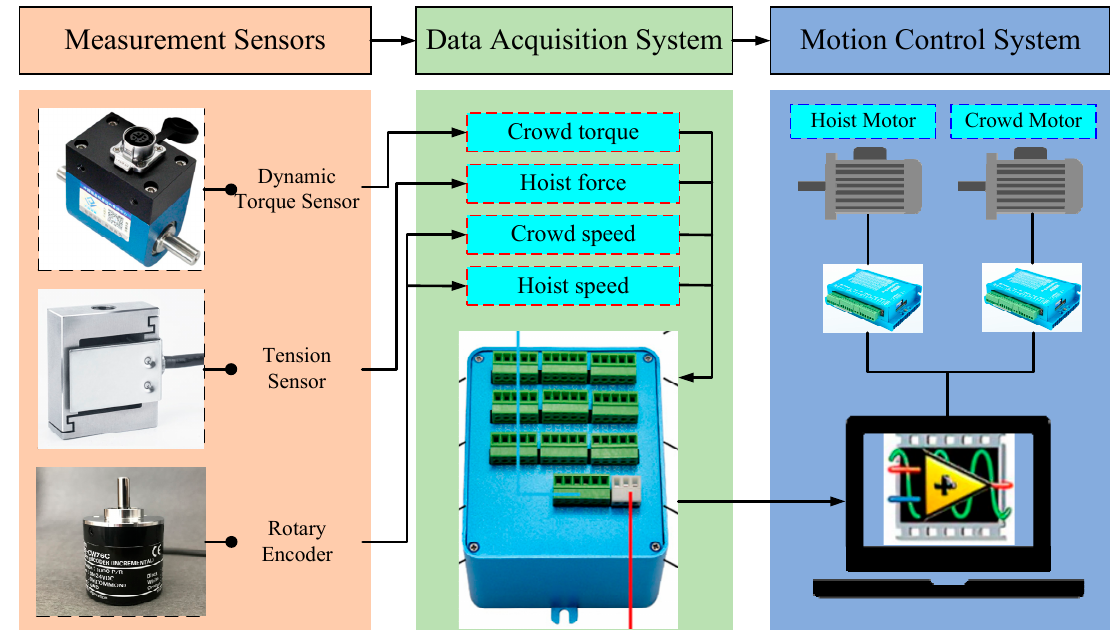
Figure 14. Motor and sensor installation positions.